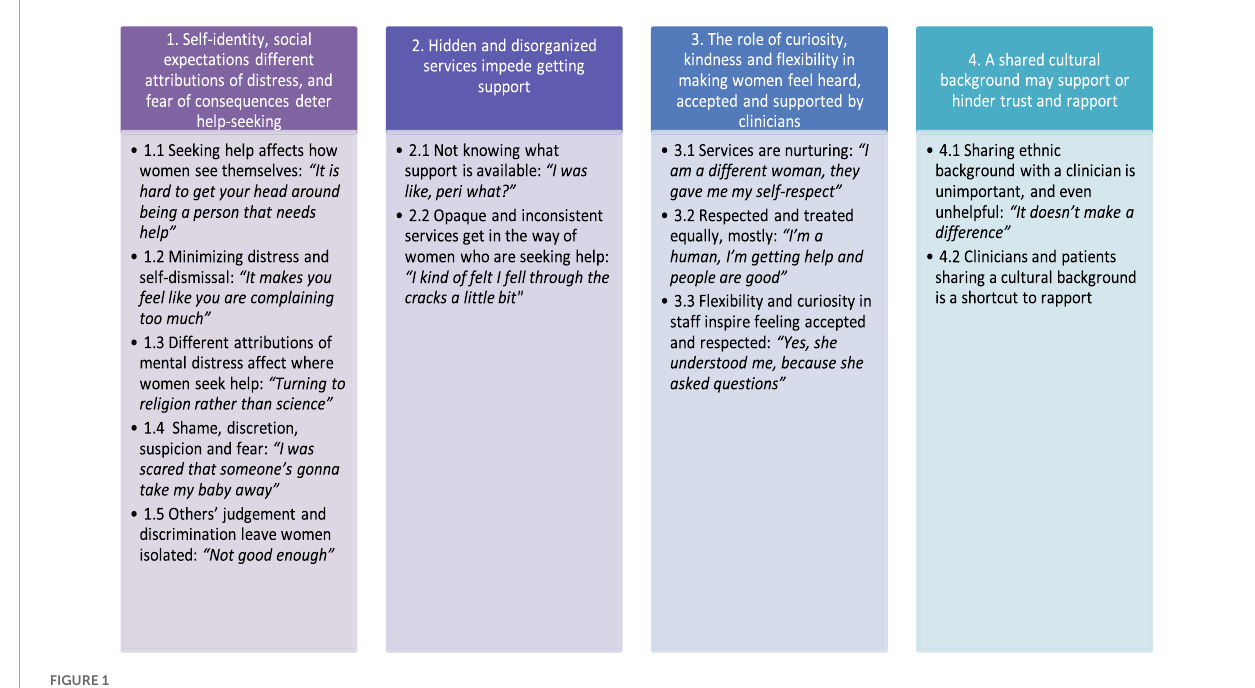
FIGURE1 Themes and